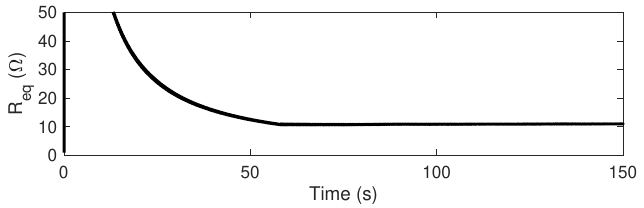
Figure 11. Equivalence resistance of the system.